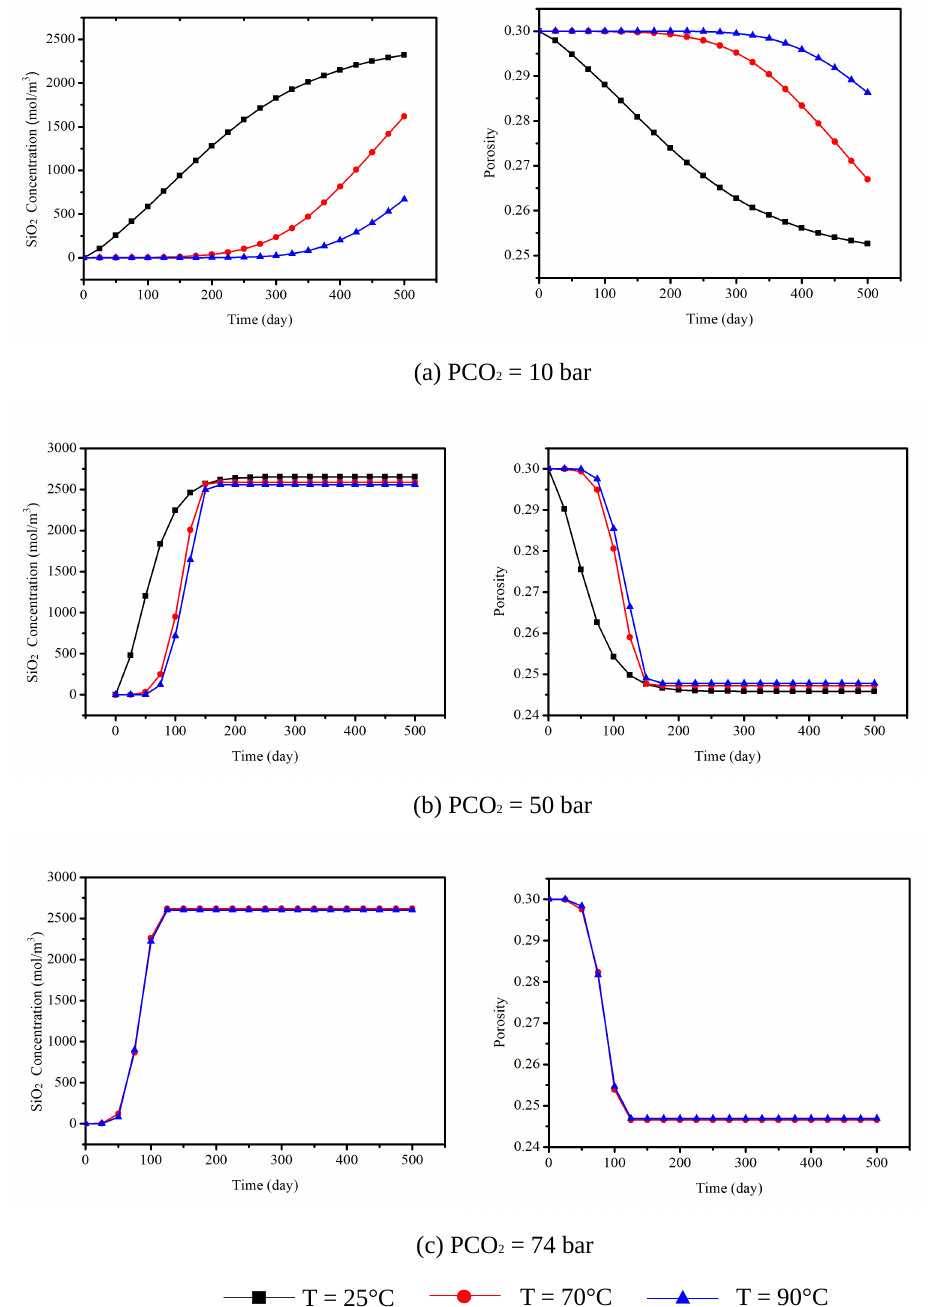
Figure 5. Variation of SiO 2 concentration and porosity with time at different atmospheric pressure and formation